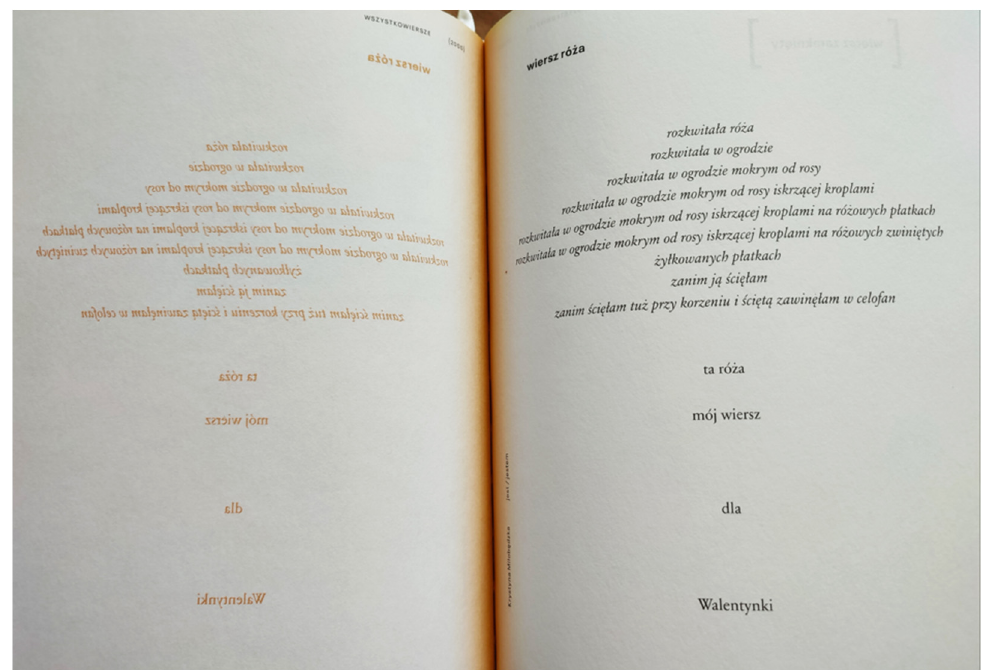
Figure 8. Mi ł ob ę dzka’s poem rose —wiersz ró ż a is composed by calligram and its reflected image in Figure 8. Miłob˛edzka’s poem rose —wiersz r ó ˙za is composed by calligram and its reflected image in color on the left in: Krystyna Mi ł ob ę dzka (2020), jest/jestem (is/I am), Lusowo: Wolno, pp. 256–57. color on the left in: Krystyna Miłob˛edzka (2020), jest/jestem (is/I am), Lusowo: Wydawnictwo Wolno, (Mi ł ob ę dzka [2000] 2020p, pp. 256–57). pp. 256–57. (Miłob˛edzka [2000] 2020p, pp.